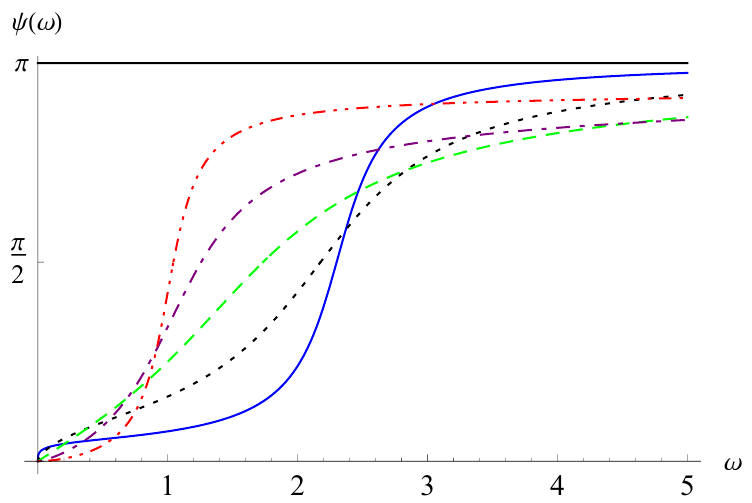
Figure 2. Curves of phase lag ψ ( ω ) for m = 1, b = 2, k = 3 and α = 0.3 (solid line), α = 0.65 (dot line), α = 1 (dash line), α = 1.35 (dot–dash line), α = 1.7 (dot–dot–dash